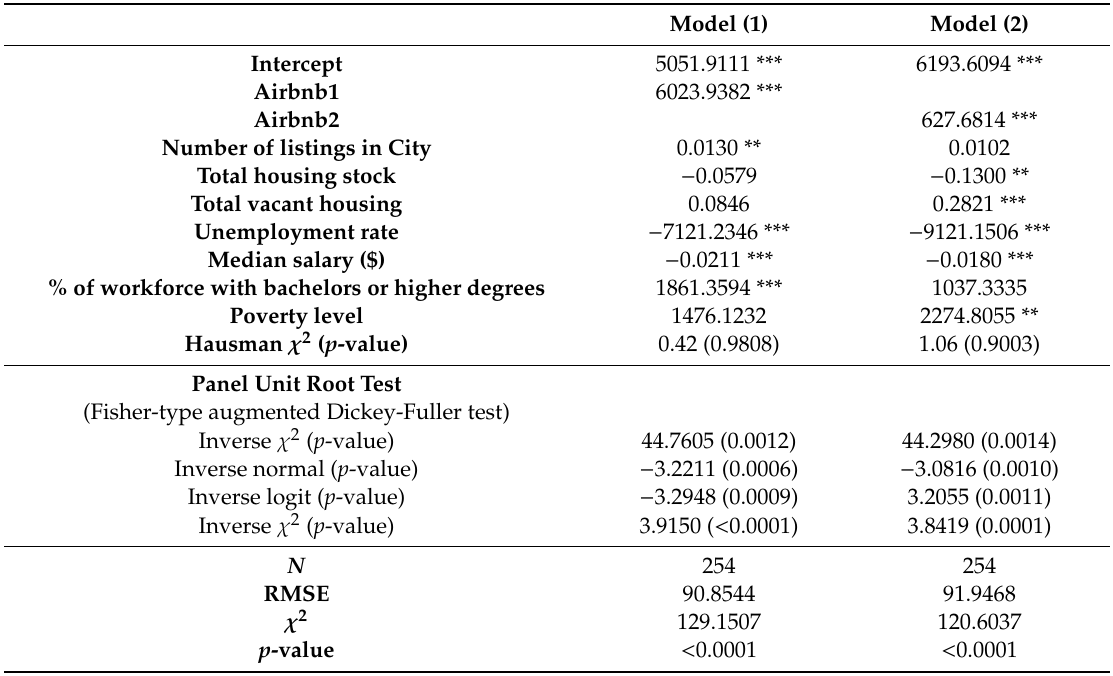
Table 5. Random E ff ects Panel Regression